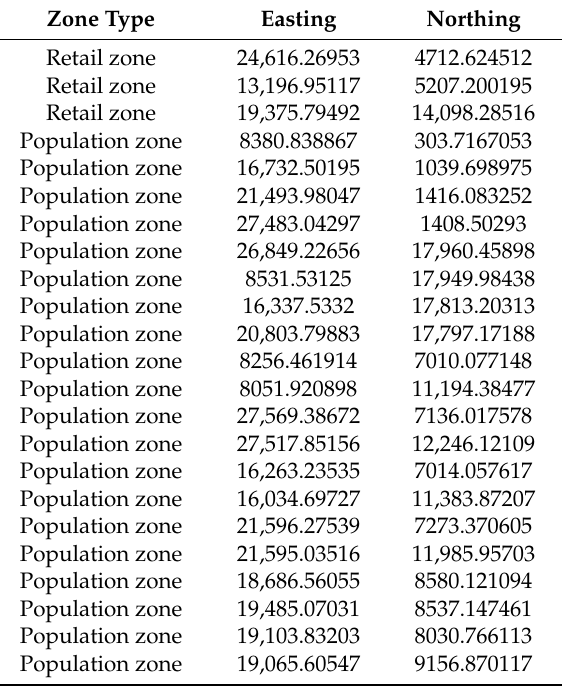
Table A2. Zone centroids for for region